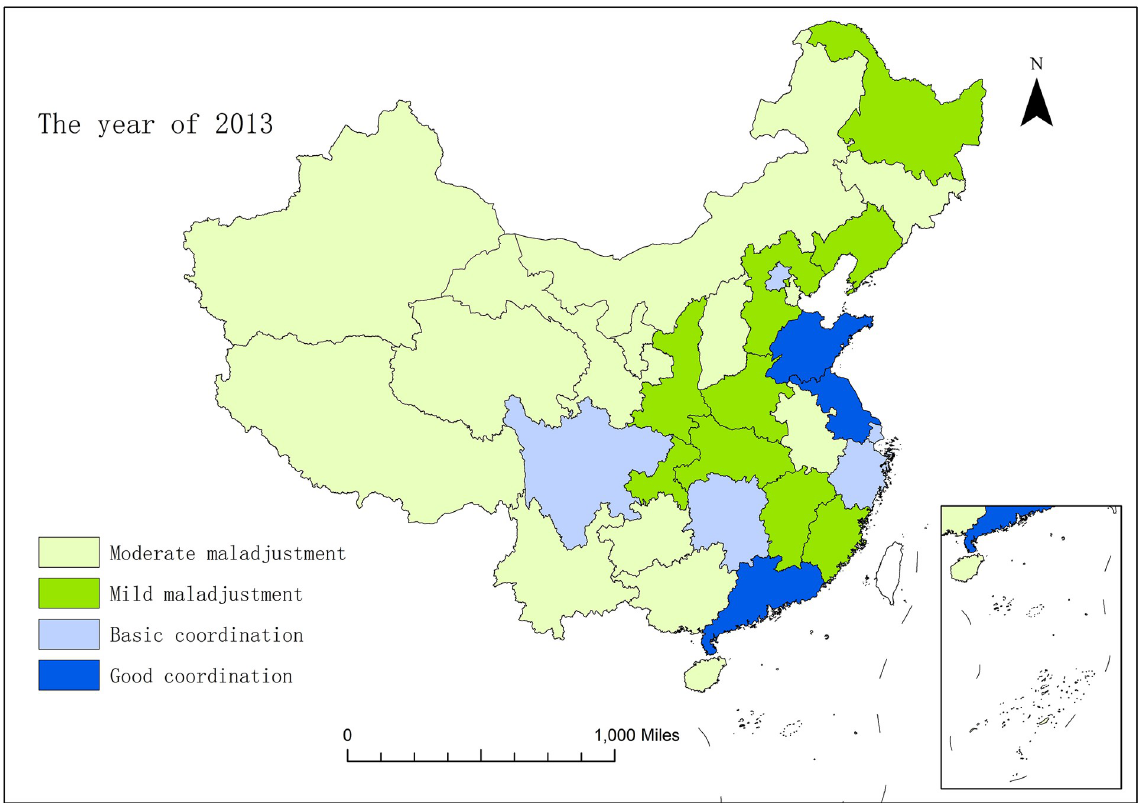
Fig 3. The spatial pattern of coupling and coordination of the sports industry and health service industry in 31 provinces and cities of China in the year of 2013.